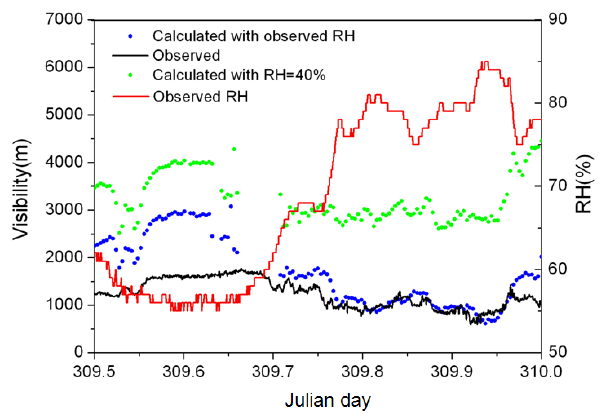
609 Fig. 10. The calculated visibility prior the Fog-1 period based upon the measured concentrations of aerosol